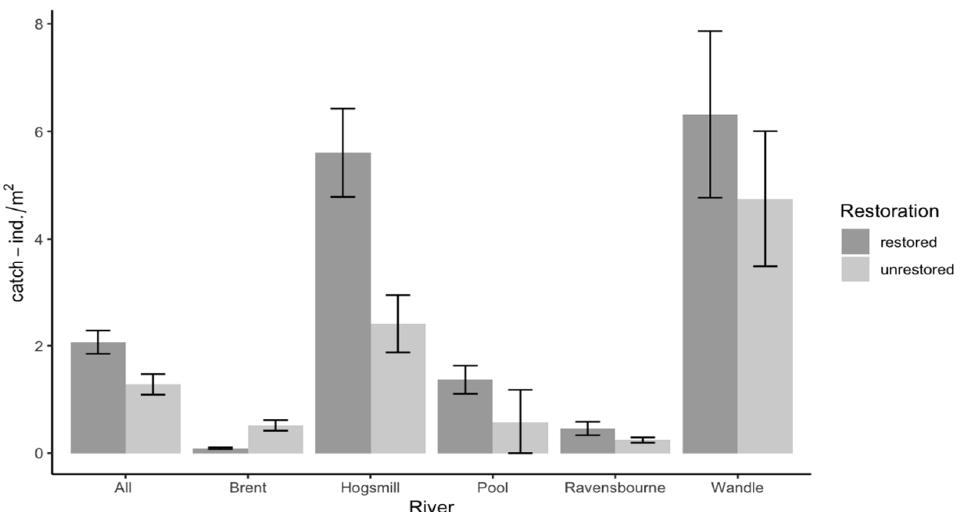
Figure 2. All catch (fish/m 2 ) for all sites, separated by river and reach. Estimates were calculated using the Carle and Strub method using 3-pass depletion electrofishing catches. Error bars are 95% confidence intervals. The data displayed in the “All” column shows all catch across the total area sampled in the restored and unrestored study reaches. Table 3. All catch (fish/m 2 ) for species across rivers and reaches, comprising all individuals caught across three 25-metre sweeps. Estimates were calculated using the Carle and Strub method and 3-pass depletion electrofishing. Estimated River Reach River